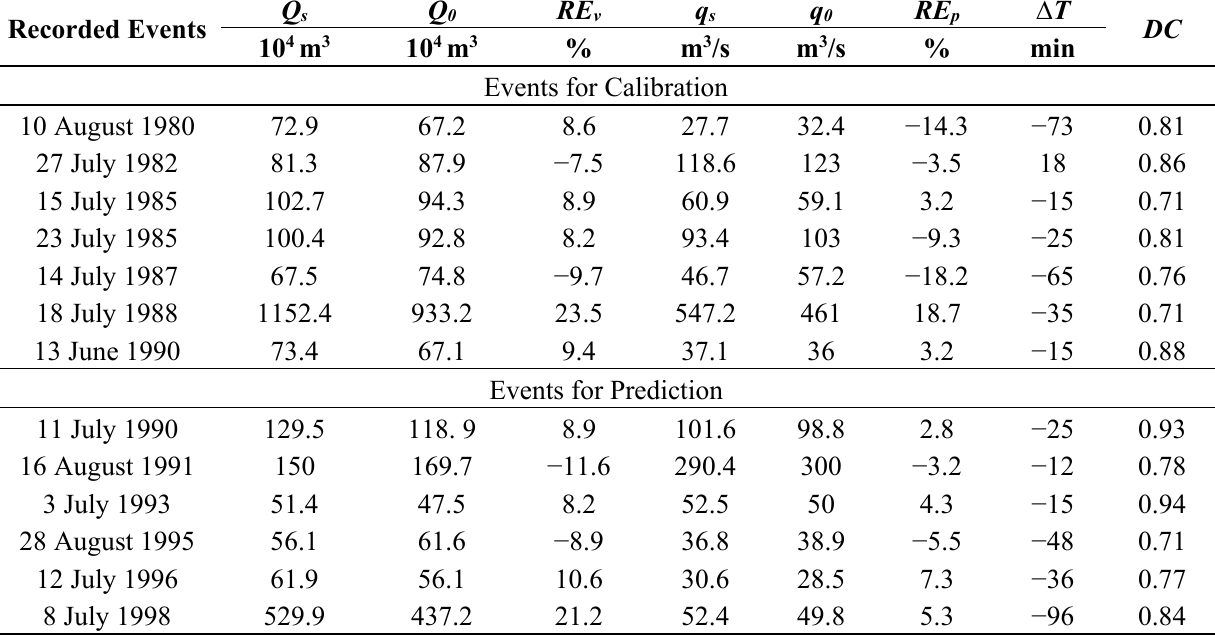
Table 8. The Modeling Results of Scheme